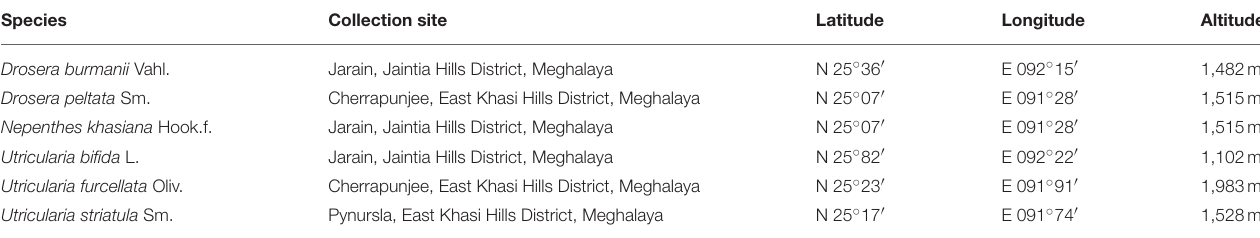
TABLE 1 | List of insectivorous plants with place of collection and GPS reading. Species Collection site Latitude Longitude Altitude